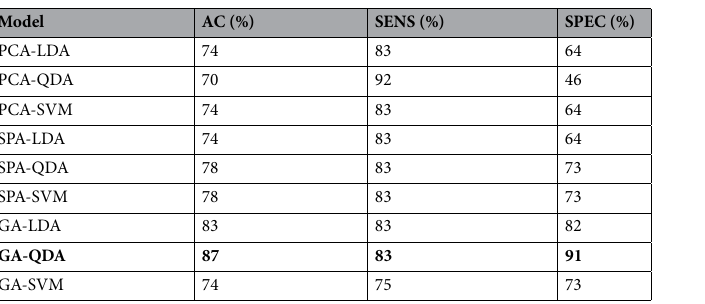
Table 2. Quality parameters calculated for the test set using different supervised classification algorithms to distinguish HIV-infected pregnant women and healthy pregnant controls. AC accuracy in %, SENS sensitivity in %, SPEC specificity in %. The best algorithm (GA-QDA) is highlighted in